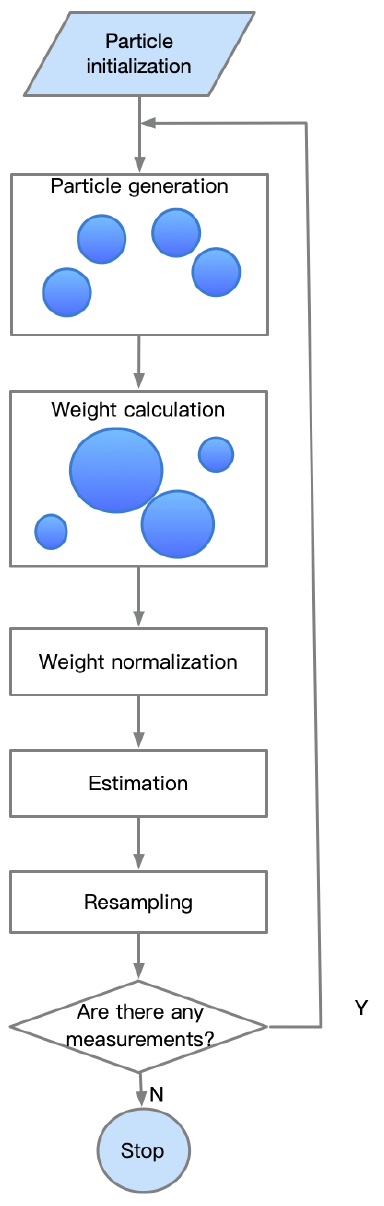
Figure 2. The flow of the particle filter algorithm. The particles are generated firstly, and then, the weights need to be calculated according to the states’ accuracy. Next, the weights are normalized, the state is estimated, and the particles are resampled. The loop is continued until all the measurement data are